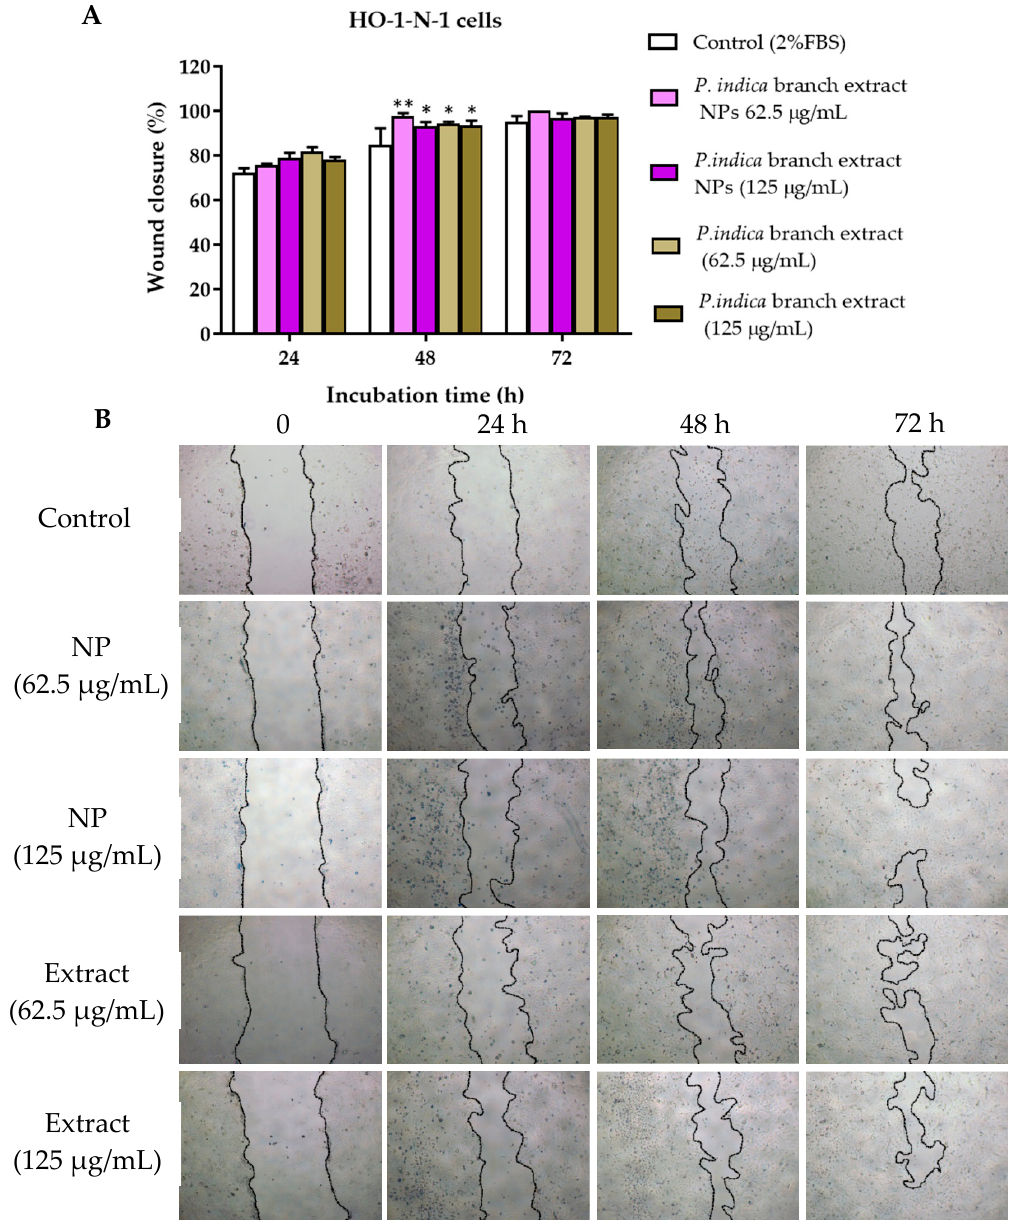
Figure 9. ( A ) Microscopic images of HO-1-N-1 cells treated with P. indica branch extract and NPs in the scratch assay. ( B ) The images were captured at 0, 24, 48, and 72 h after incubation. The data represent mean ± SEM of three experiments. * and ** indicate p < 0.05 and p < 0.01, respectively compared with control.